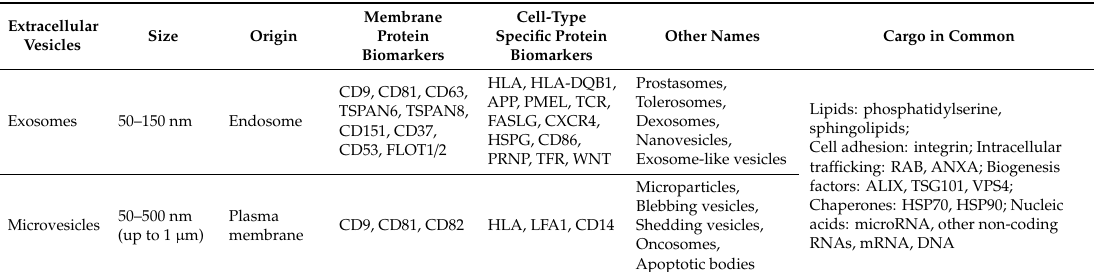
Table 1. Comparisons of extracellular vesicle